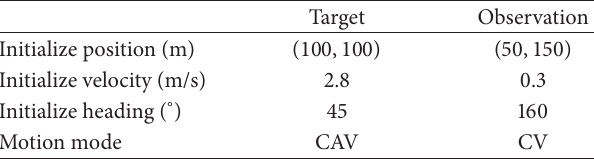
Table 1: Target and observation station